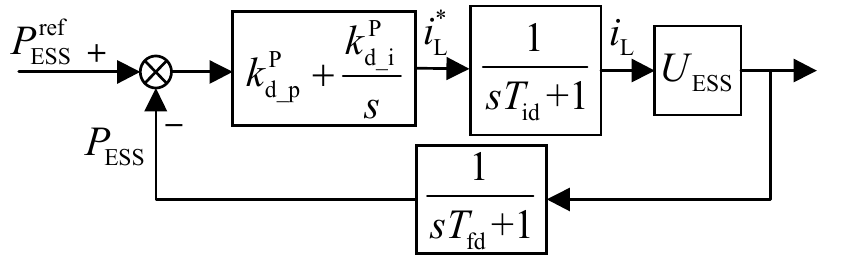
Figure 10. The simplified block diagram of ESS.